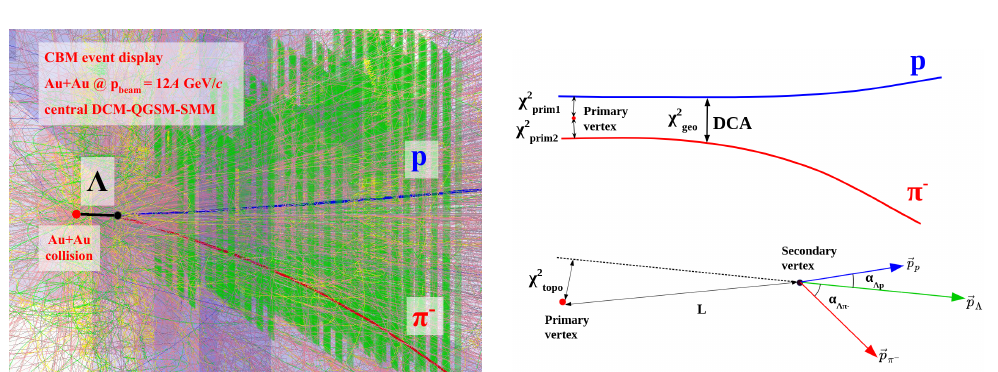
Figure 1. ( left ) The CBM event display illustrating the multi-particle environment which complicates the hyperon decay reconstruction. ( right ) Schematic view of the Λ → p π − decay which indicates parameters used for the Λ candidate selection. See text for description of notations.